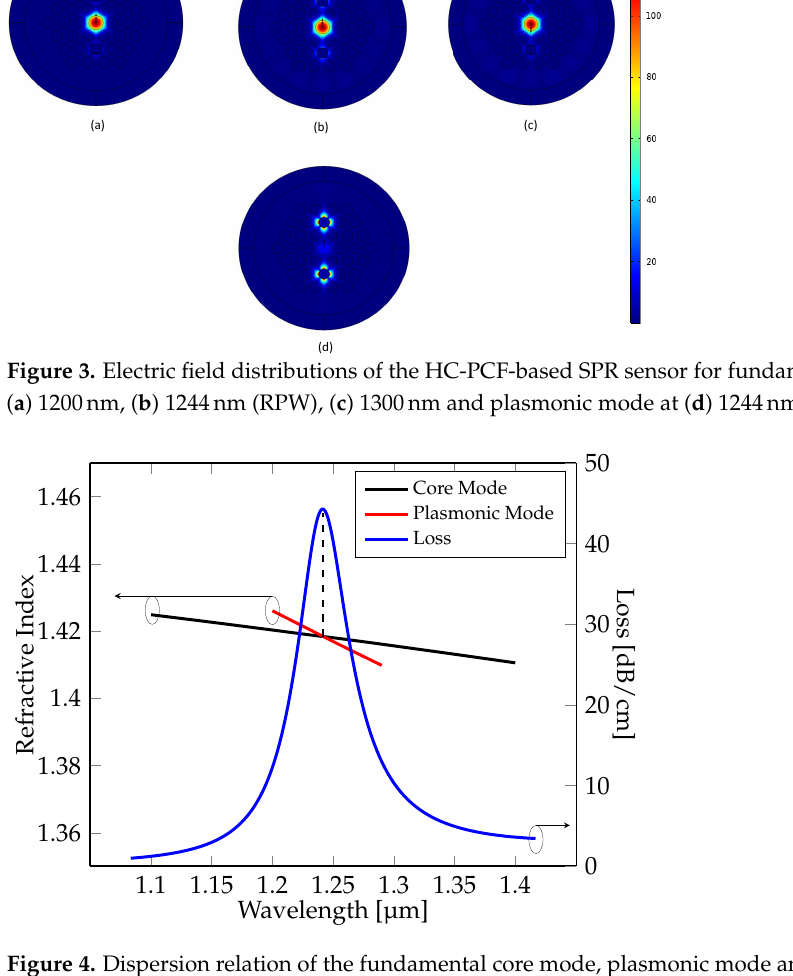
Figure 4. Dispersion relation of the fundamental core mode, plasmonic mode and confinement loss for analyte with RI of n a =